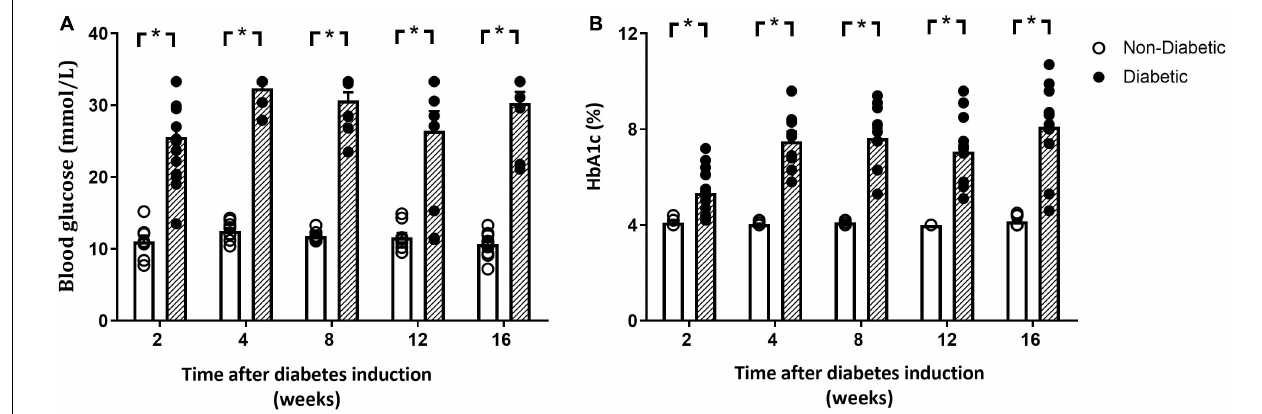
FIGURE 1 | Blood glucose and glycated hemoglobin. Both blood glucose (A) and glycated hemoglobin (B) levels were elevated at each time point. Data are presented as mean ± SEM and analyzed using a two-way ANOVA with Benjamini and Hochberg post hoc test. * P < 0.05 vs age-matched non-diabetic mice. n = 8–16/group (refer to Supplementary Figure S1 ).